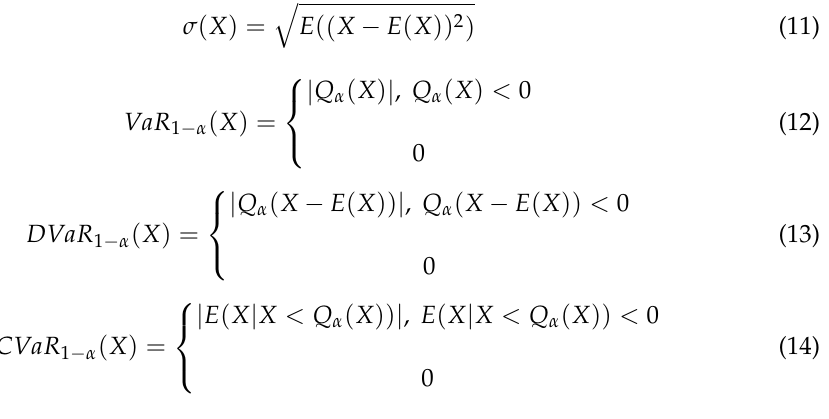
Table 6. Calculation and conversion of position-variant risk measures into position-invariant risk measures.